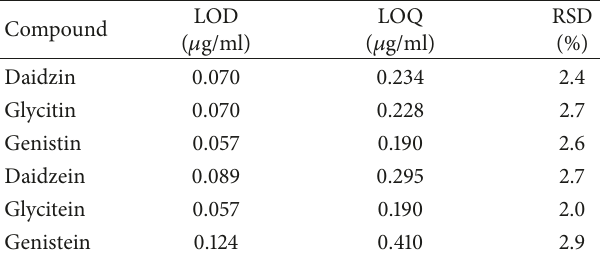
Table 1: Estimated LOD and LOQ obtained for the standard isoflavones, together with the precision data of the method.